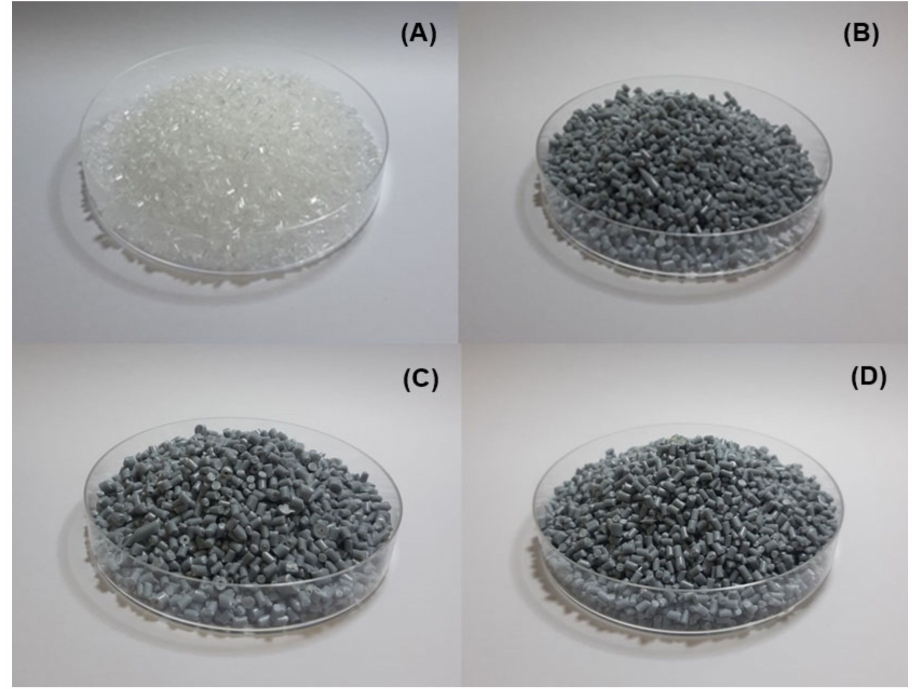
Figure 1. Feasibility images of different compounds. ( A ) vPP, ( B ) rPP20, ( C ) rPP30, and ( D ) rPP40.